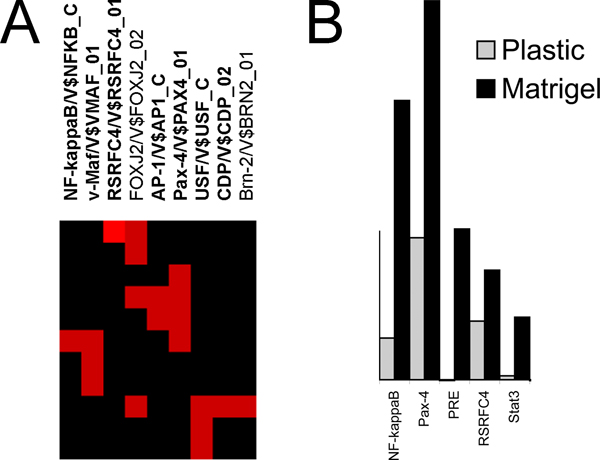
Transcription factor activity identified in silico and in vivo. A) Example of TREs overrepresented in first ontological cluster. Several genes (vertical) share common TREs (horizontal), highlighted by red. Results were filtered to show only TREs overrepresented at p < 0.05 and FDR < 0.3. TREs in bold show a significant increase in expression on crECM compared to plastic confirmed by transcription factor array experiment. B) Example of changes in binding activity of a few TFs on plastic and crECM. Gray/black bars show binding activity on plastic/crECM, respectively.